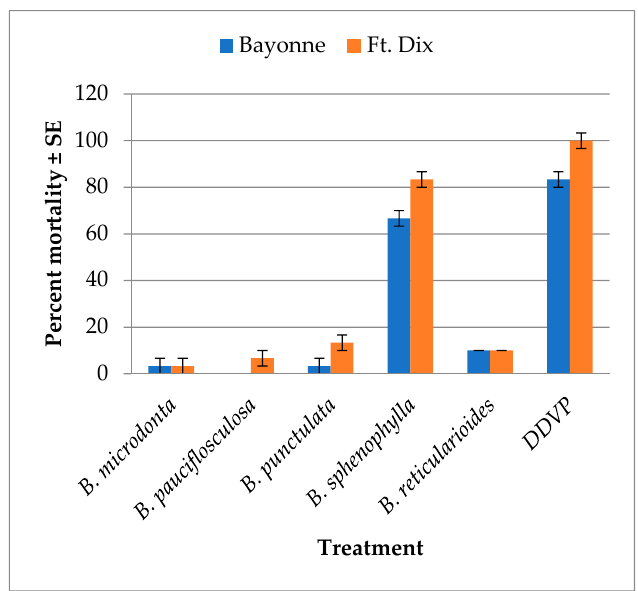
Figure 2. Mean percent mortality (±SE) caused by the essential oils of five species of Baccharis against two strains of bed bugs ( Cimex lectularius ) 24 h after treatment in a fumigation bioassay. Essential oil dose: 250 μ g/125 mL of air, 2,2-dichlorovinyl dimethyl phosphate (DDVP) used as standard (2 μ g/125 mL of air). Mean and standard error were calculated in John´s Macintosh Project (JMP) 10.0. None of the EOs showed high mortality when applied topically at 50 μ g/bug. Only in B. punctulata did the mortality reach 20% seven days after the treatment (Figure 3). In residual study, none of the EOs produced mortality in bed bugs seven days of exposure at 100 μ g/cm 2 .